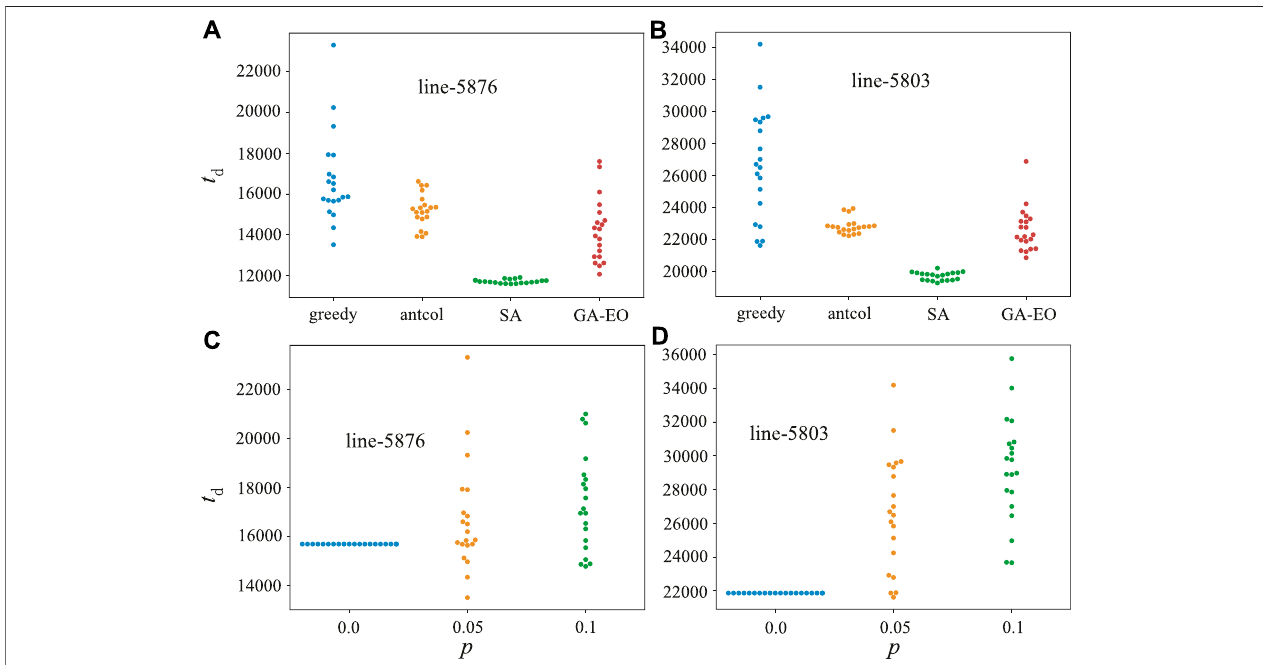
FIGURE 4 | (color online) (A,B) Under the four algorithms (greedy, antcol, SA, and GA-EO), the optimal driving time for a single inspection team to perform the inspection task with 20 times of independent running. (C,D) For different perturbation parameters p of the greedy algorithm, the optimal driving time for a single inspection team to perform the inspection task with 20 times running independently. (A,C) Line-5876. (B,D) Line-5803.